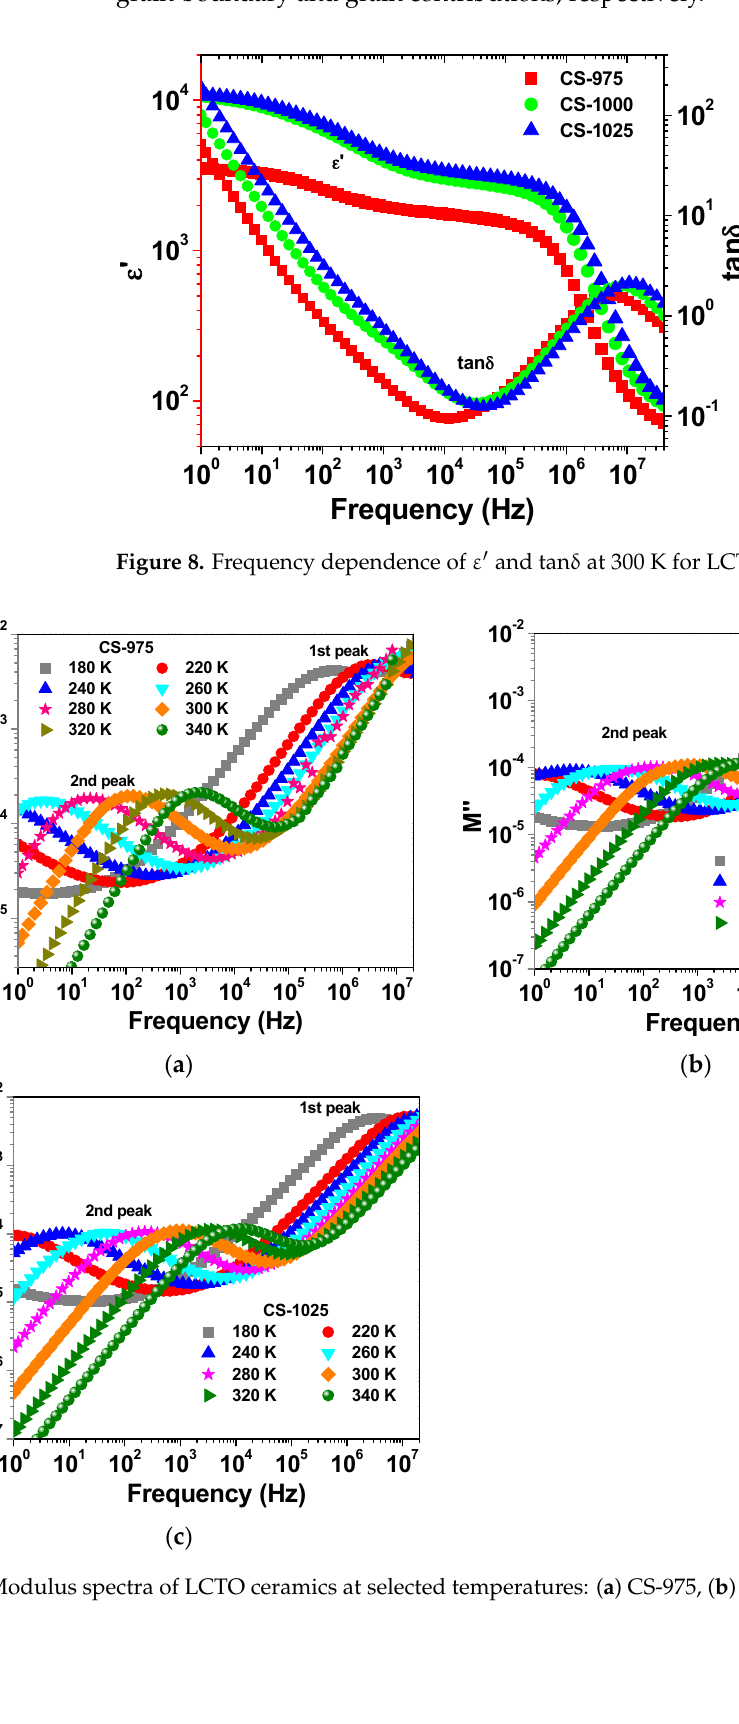
Figure 7. Frequency dependence of ε ’ at selected temperatures for LCTO ceramics; ( a ) CS-975, ( b ) CS-1000, and ( c ) CS-1025.